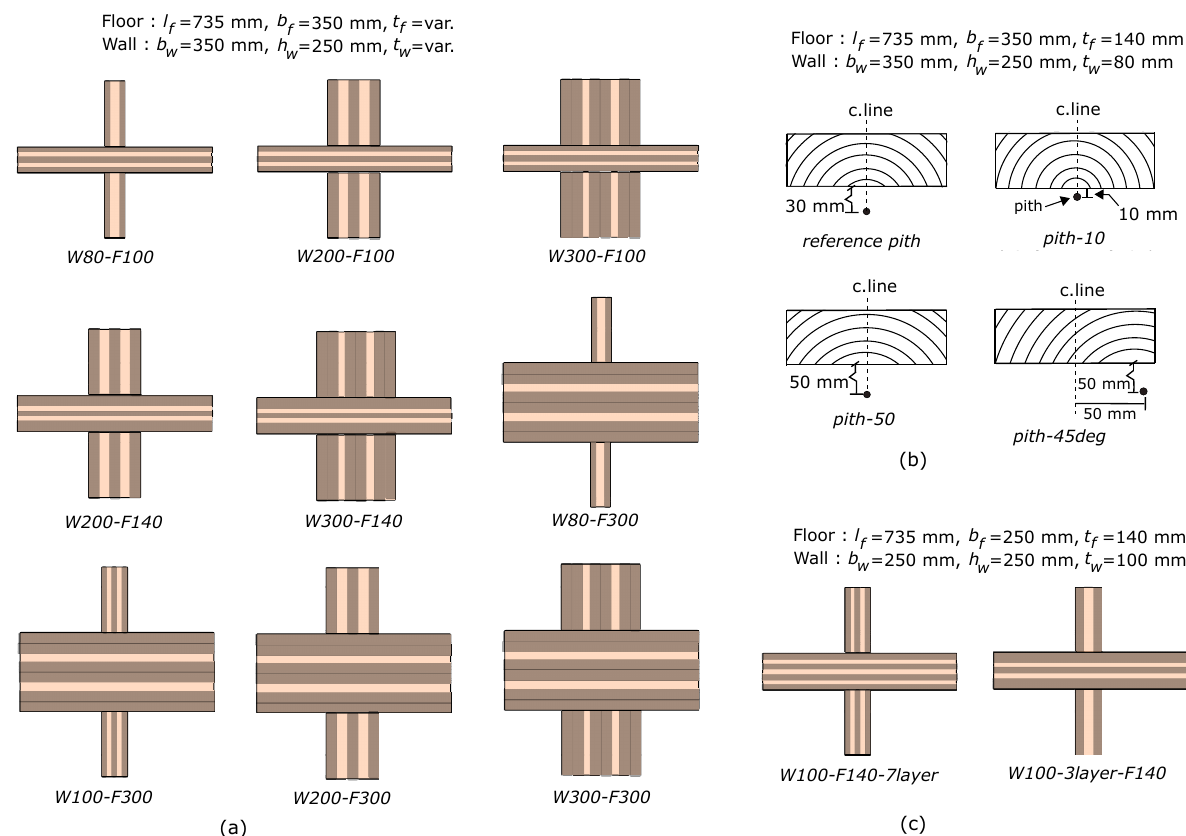
Figure 2. Parameter study of the influence of ( a ) wall and floor thicknesses, ( b ) pith location, and ( c ) number of